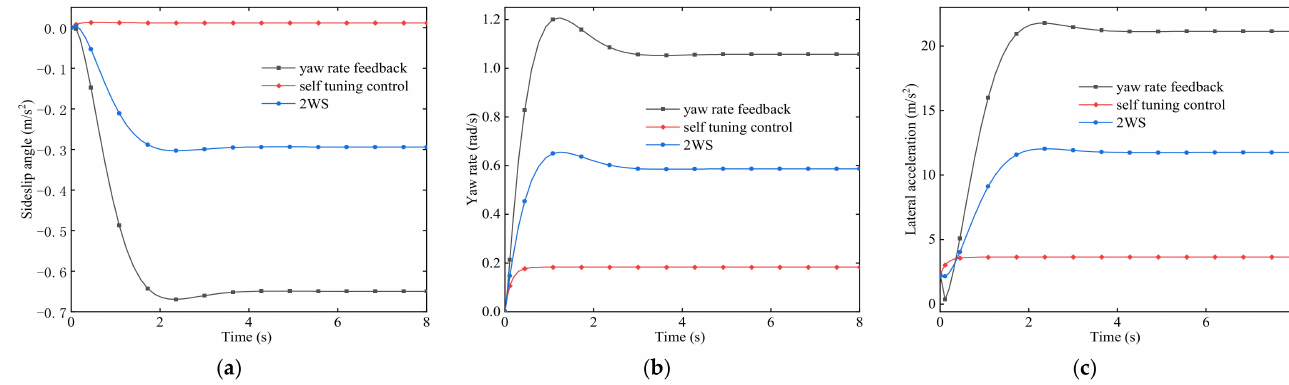
Figure 6. Response comparison. ( a ) Sideslip angle. ( b ) Yaw rate. ( c ) Lateral acceleration.